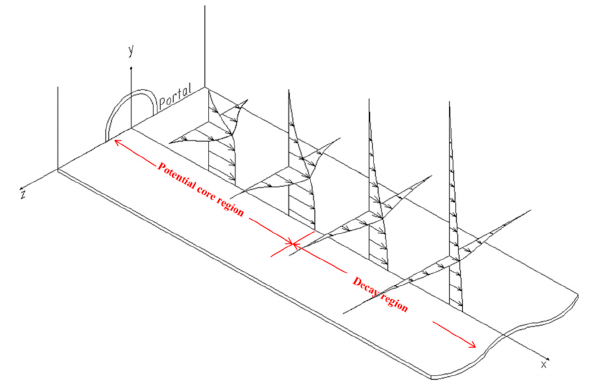
Figure 7. The sketches of three ‐ dimensional velocity profiles of jet flow at tunnel exit.